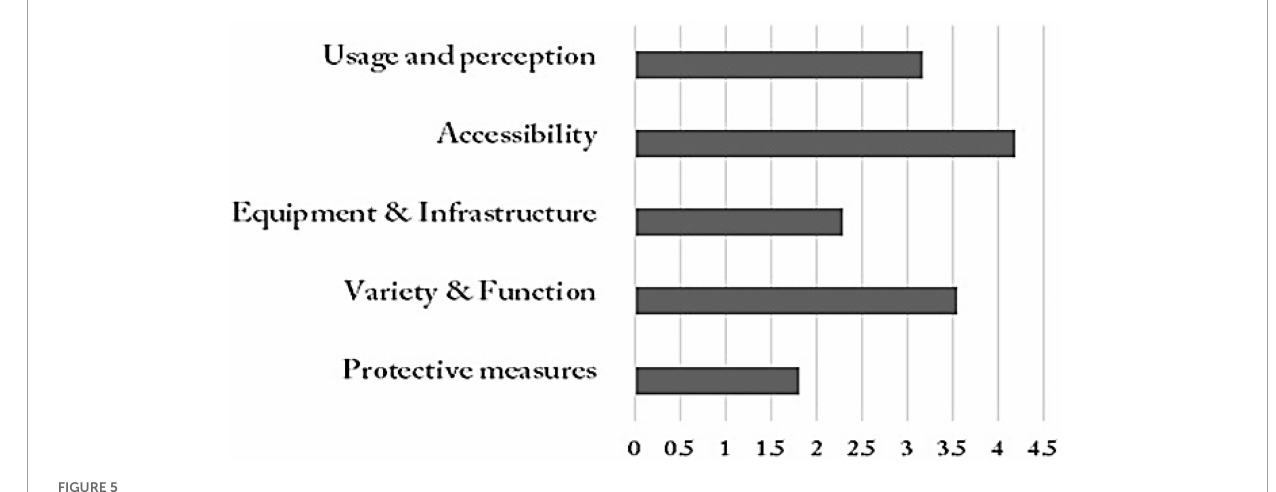
FIGURE5 Satisfaction of current status in EWP.